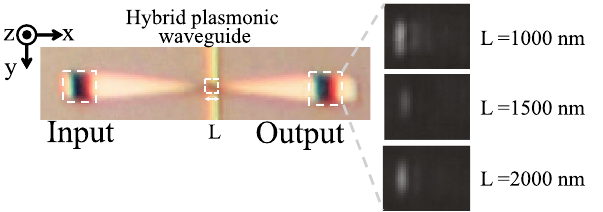
Figure 5. Optical microscope images of the fabricated structure and near-infrared camera images at the output port for different lengths of L = 1000, 1500, and 2000 nm.